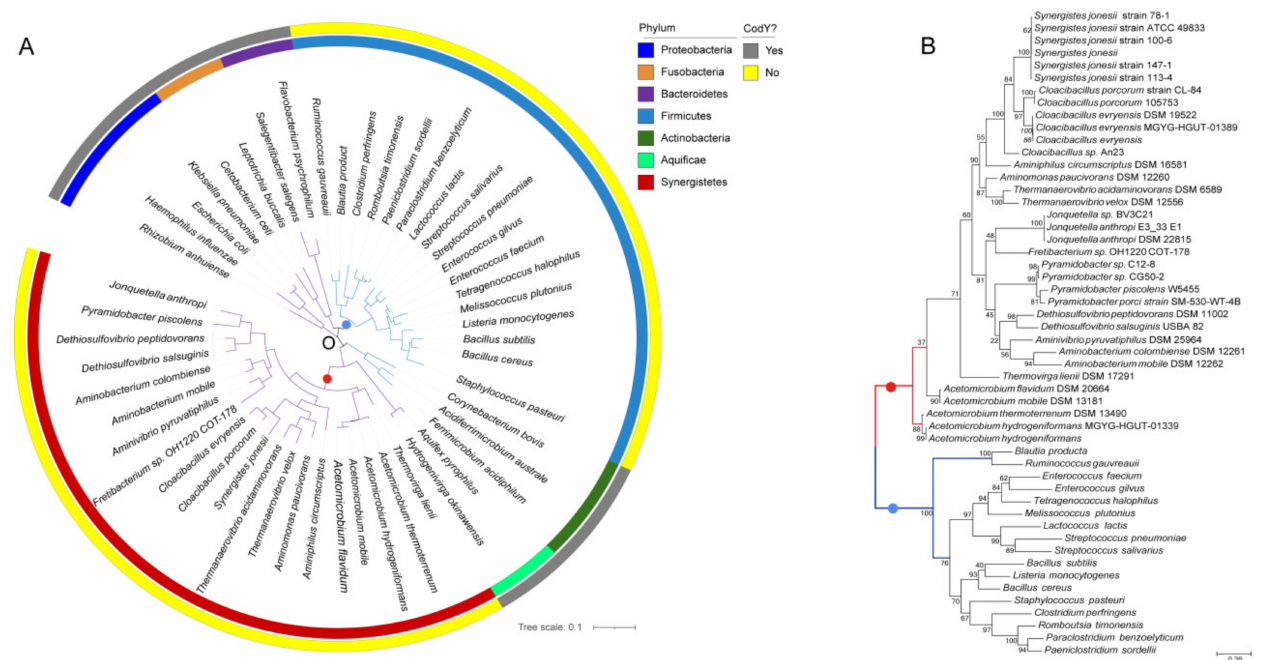
Figure 2. The phylogenetic relationship of species and the CodY/CodY-like proteins of Firmicutes and Synergistetes. ( A ) Phylogenetic tree of the 16S rRNA of representative species from various bacterial phyla. The presence (grey) and absence (yellow) of a codY gene in the chromosome of a species is shown on the outer circle. Species of different phyla are color-coded and shown in the inner circle. The phylum information is shown on the right. An ML distance tree based on the 16S rRNA sequences of 51 species from different phyla is shown inside the circle. Gram-negative bacteria are indicated by purple branches and Gram-positive bacteria are indicated by blue branches. ( B ) An ML distance tree based on 52 CodY homologous protein sequences of different species in the phyla Firmicutes and Synergistetes. The phylum Synergistetes is indicated by the red branch and the phylum Firmicutes is indicated by the blue branch. The numbers on the branches indicate the percentage of calculations performed by